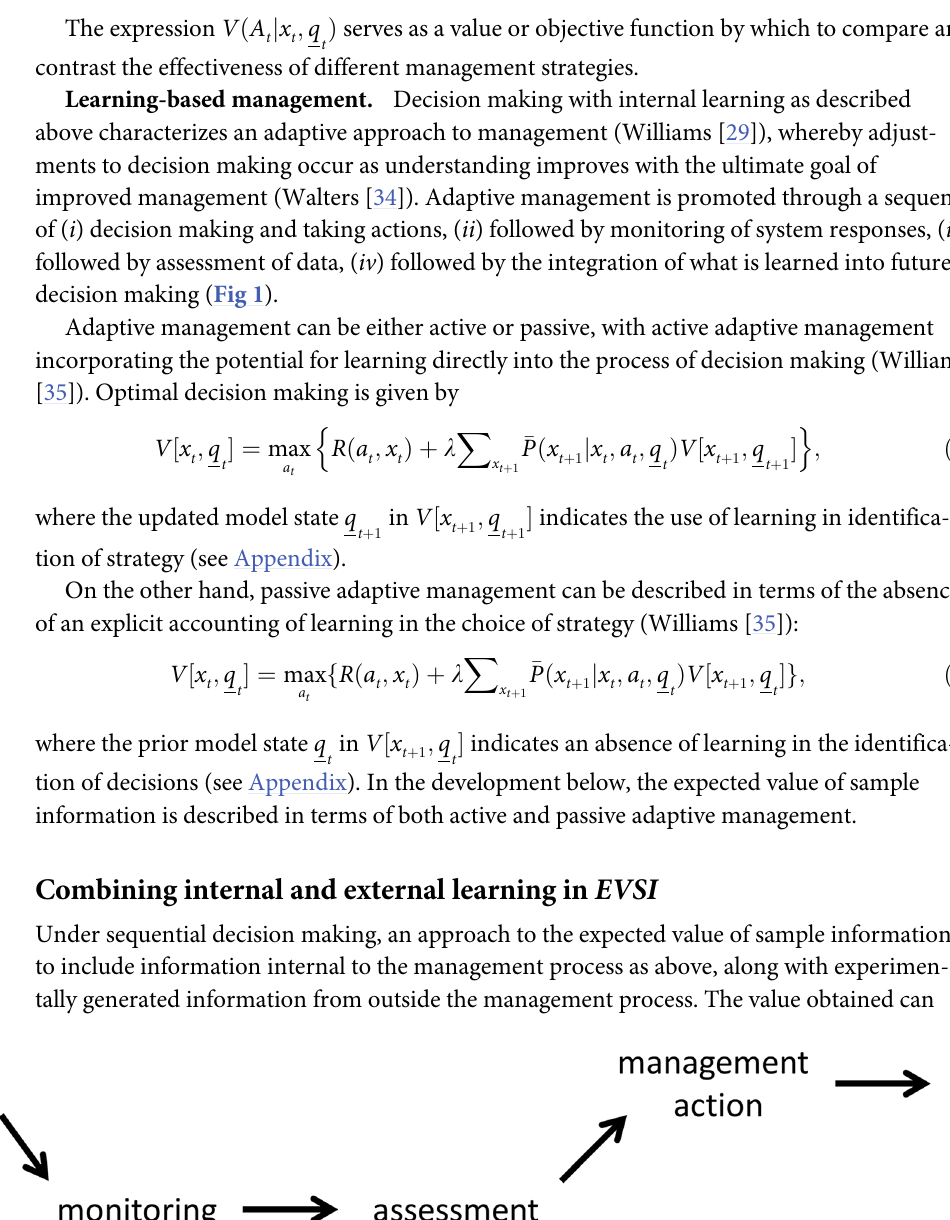
PLOS ONE | https://doi.org/10.1371/journal.pone.0199326 June 29,